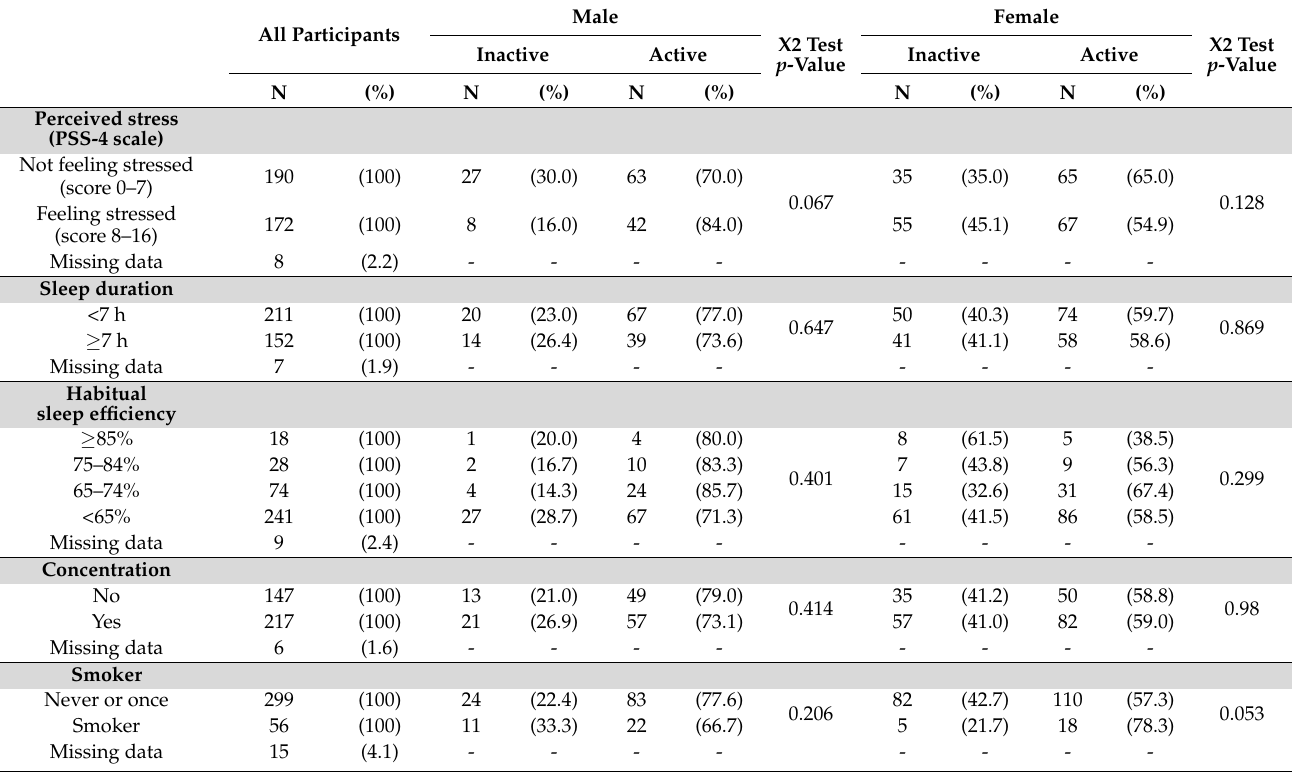
Table 4. Physical activity and mental-health-related